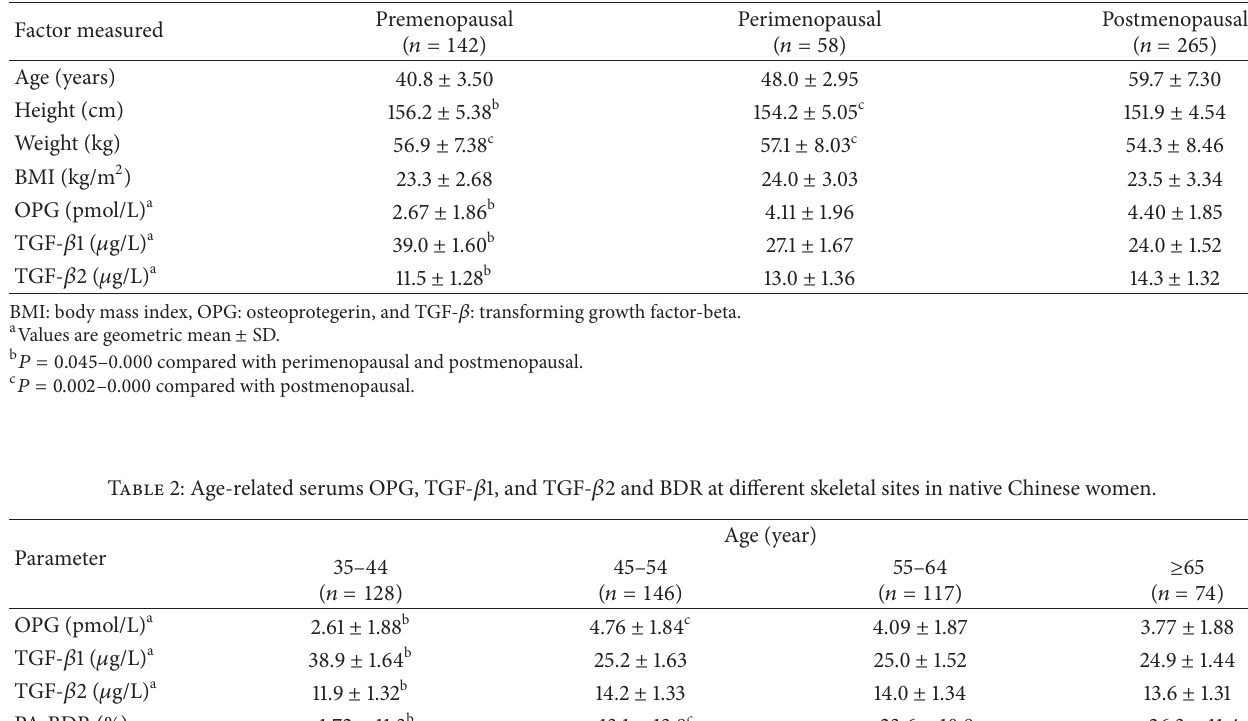
Table 1: Demographics and clinical characteristics of the study subjects.